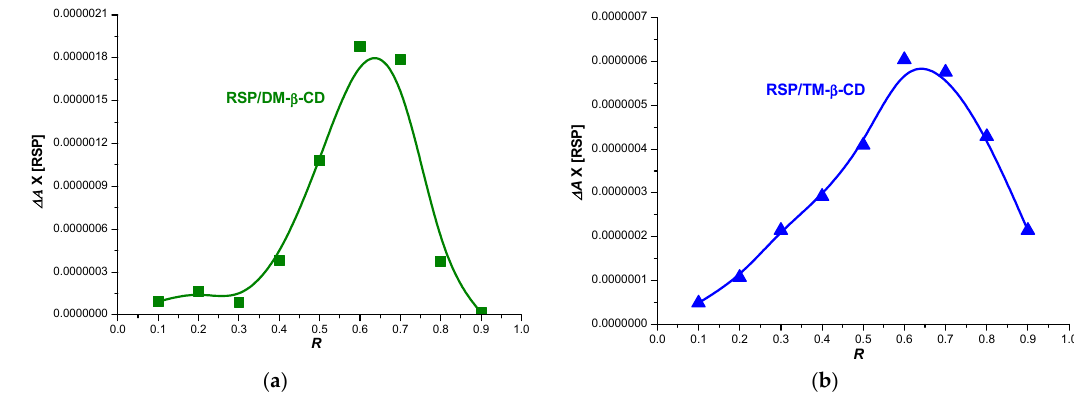
Figure 2. Job’s plot corresponding to RSP/heptakis(2,6-di-O-methyl)- β -cyclodextrin (DM- β -CD) ( a ) and RSP/heptakis(2,3,6-tri-O-methyl)- β -cyclodextrin (TM- β -CD) ( b ) inclusion systems.